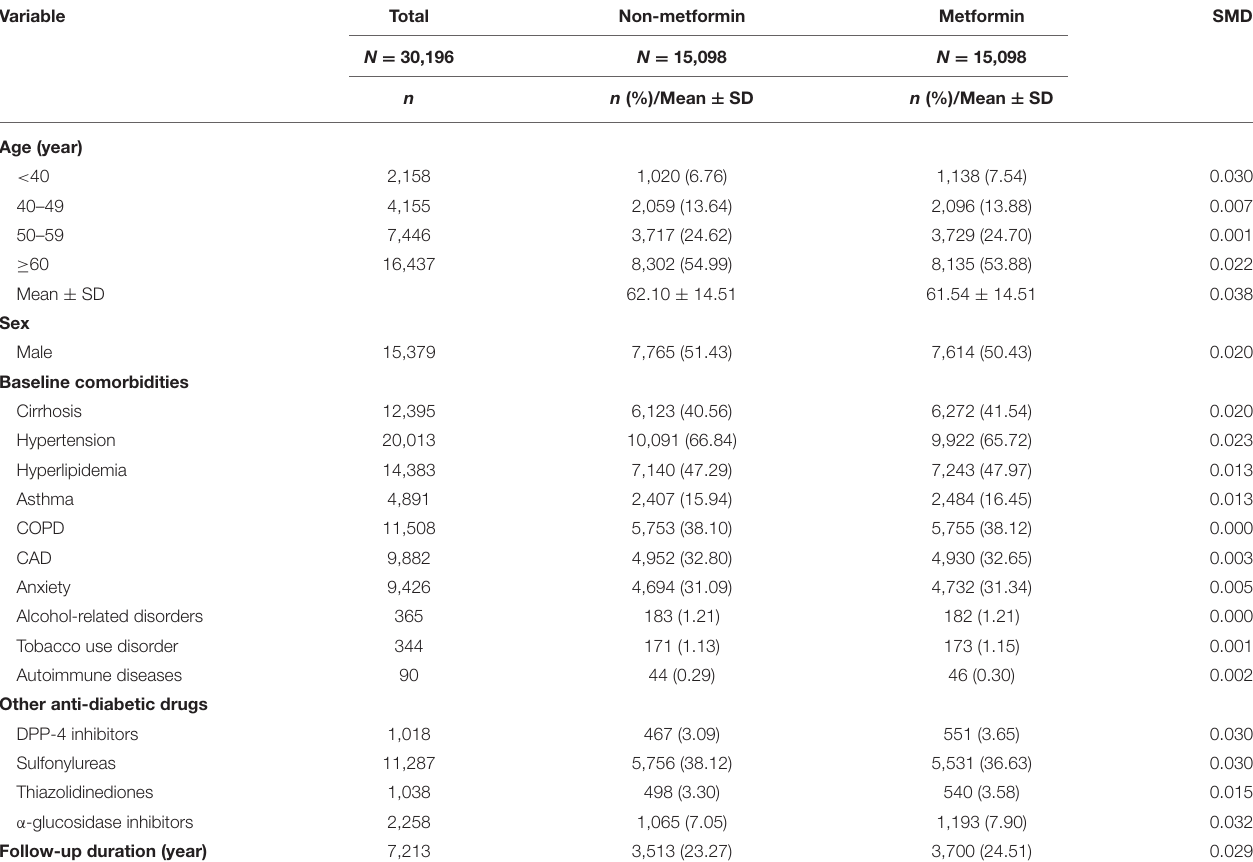
TABLE 1 | Demographic characteristics, comorbidities, and other anti-diabetic drugs in type 2 diabetic patients with and without metformin. Variable Total